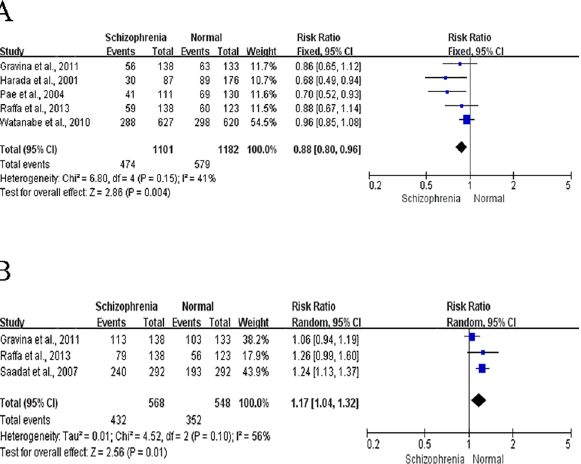
Fig 3. Forest plots for meta-analysis of GSTM1/T1 polymorphisms and SCZ. A. the summary of RRs with 95% CIs for GSTM1 present genotype; B. the summary of RRs with 95% CIs for GSTT1 present